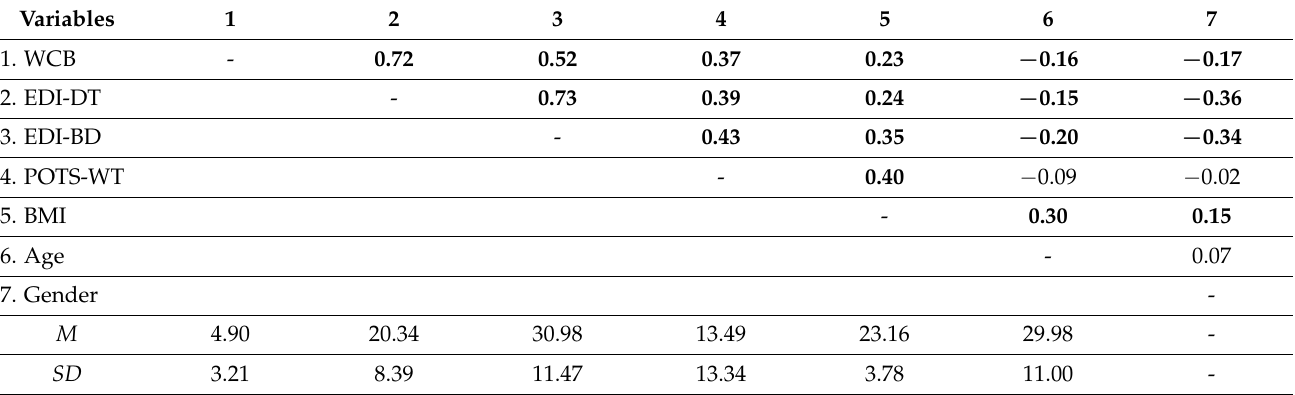
Table 3. Descriptive statistics and correlations among the variables of the study in the adult sample.